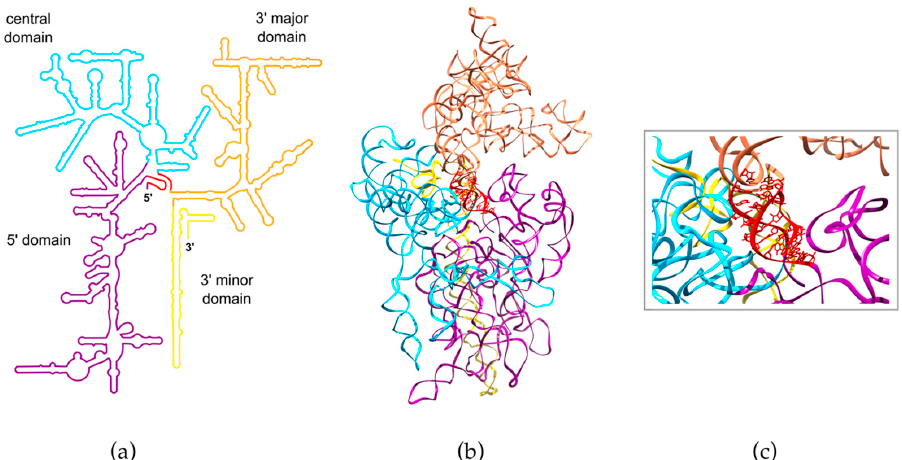
Figure 3. Folding of the human 18S rRNA. The 18S rRNA folds into 45 helices that distribute into four structural domains distinguished here by different colors. These domains assemble around the pseudoknot (red) formed by nucleotides located at the 5 ′ end that hybridize with nucleotides located ~1200 residues farther down in the primary sequence, at the junction between the central domain and the 3 ′ major domain. ( a ) Secondary structure of the 18S rRNA. ( b ) Structure of the 18S rRNA within the 40S subunit. ( c ) Enlarged view of the pseudoknot. The 3D structure in ( b , c ) was generated from PDB file 4UG0 [19].